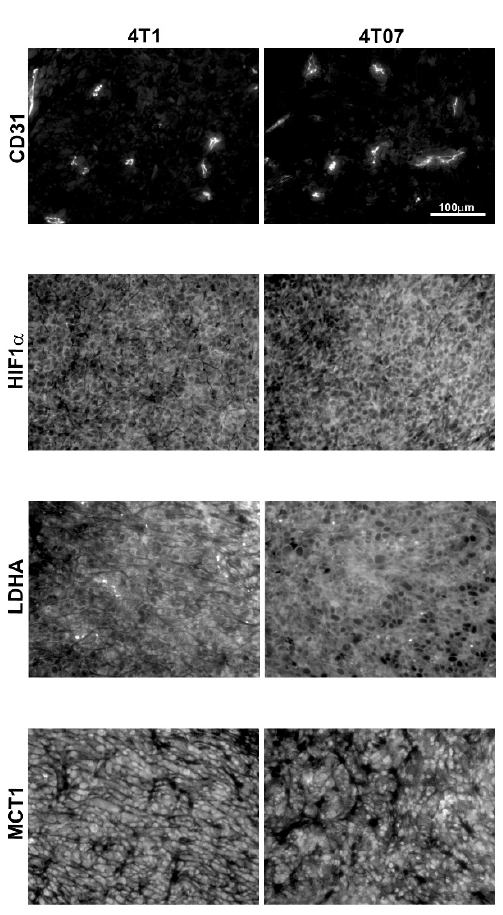
Figure A1. Representative images of CD31, HIF-1 α , LDHA, and MCT1 immunofluorescence in 4T1 vs. 4T07 tumors.